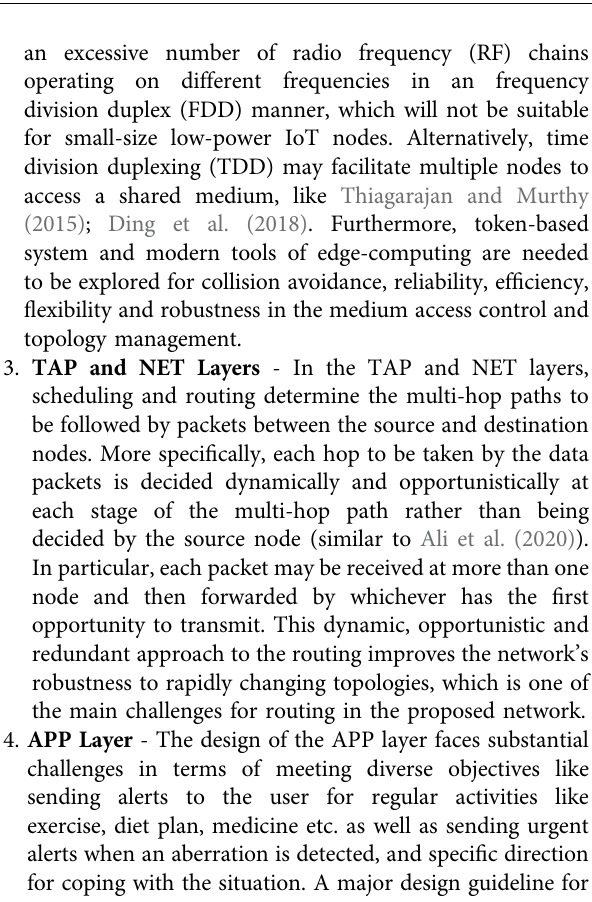
Frontiers in Communications and Networks |